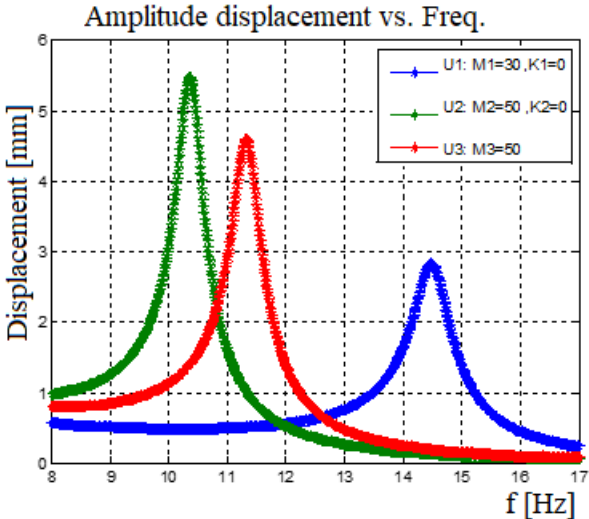
Figure A9. Amplitude displacement for no spring connections ( K 1 = K 2 = 0)—three bimorphs interconnected by two springs case.